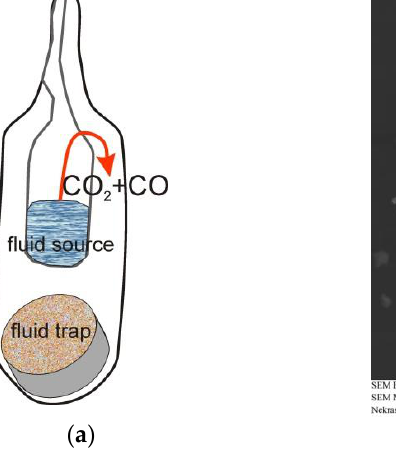
Figure 2. The scheme of our experiments ( a ) oxalate or (and) carbonate were placed in the small open capsule within the welded larger one. On the bottom of the large capsule, fluid trap was placed. Fluid trap was a powder of albite or porous ceramics ( b ) SEM image of the piece of the quartz glass ceramics after experiment (qz98).